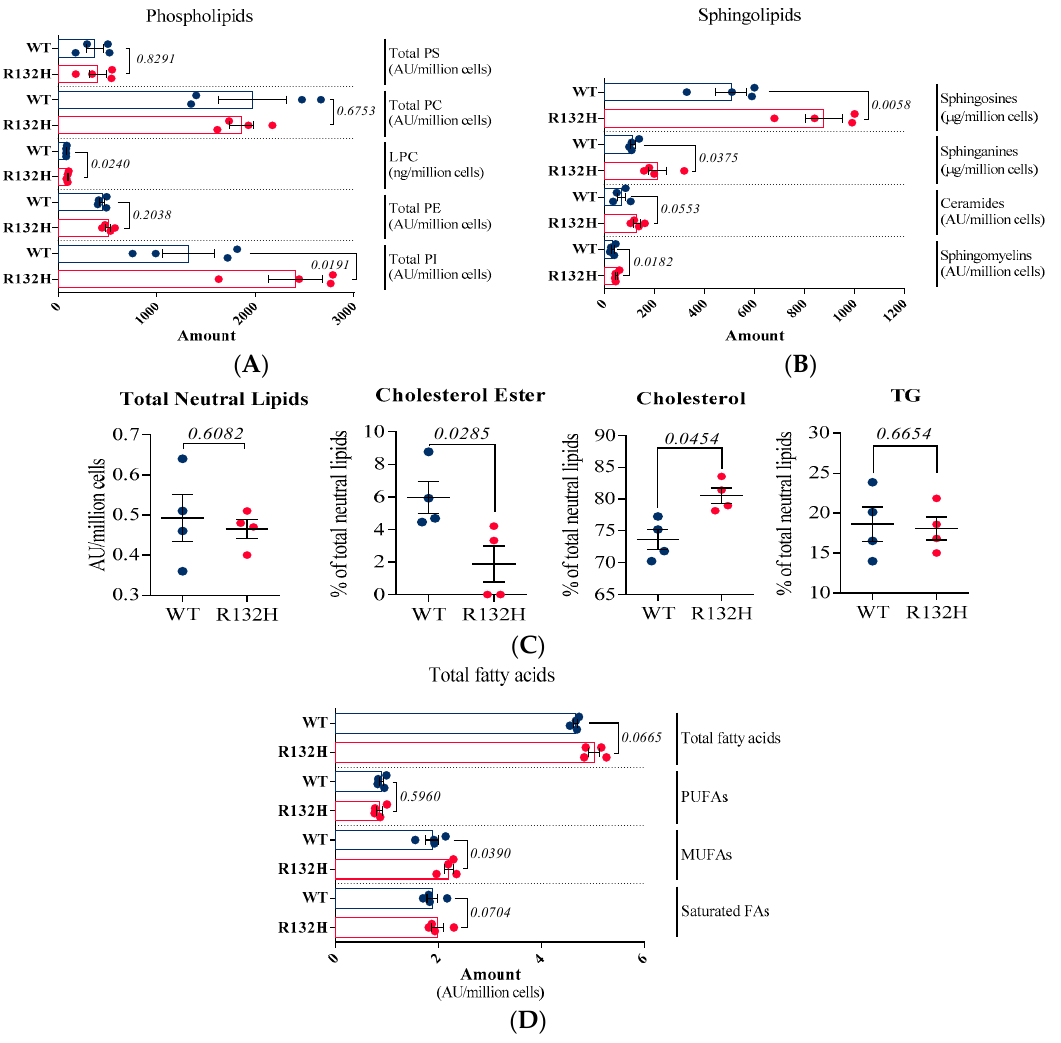
Figure 2. Lipidomic analysis in HL60 AML IDH1 WT (blue dots) and IDH1 R132H cells (red dots) ( n = 4). ( A ) Phospholipids; ( B ) Sphingolipids; ( C ) Neutral lipids and percentages of each of its constituents; and, ( D ) Total Fatty Acids.